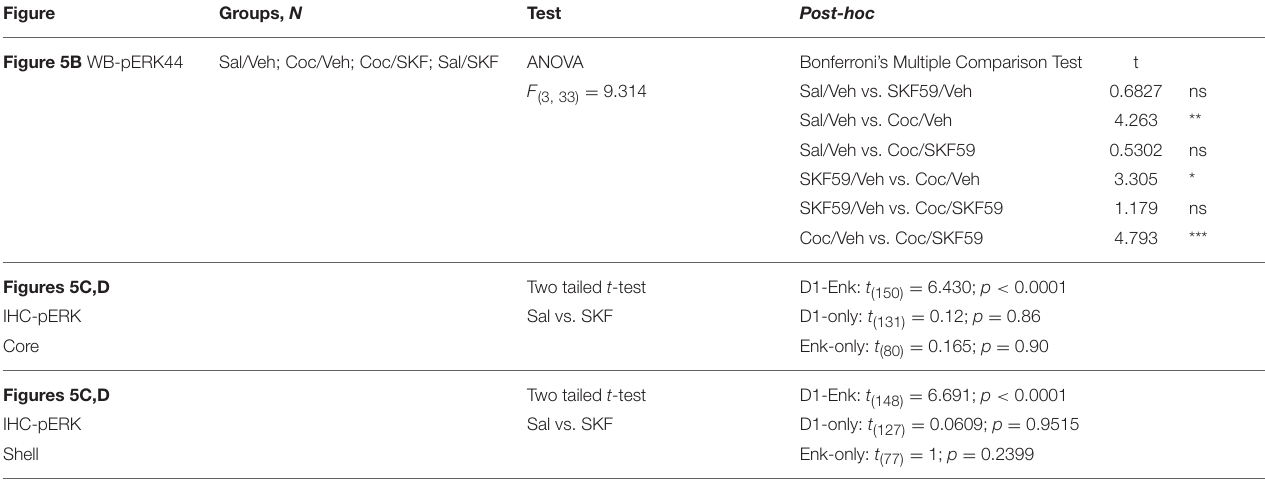
Figure Groups, N Test Post-hoc Figure 5B WB-pERK44 Sal/Veh; Coc/Veh; Coc/SKF; Sal/SKF ANOVA Bonferroni’s Multiple Comparison Test